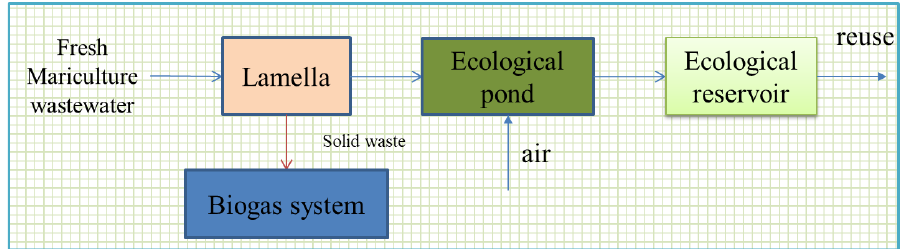
Figure 2. Biological nutrients removal of raw mariculture wastewater. Inclined tube settling tank (Lamella) is suggested for the removal of the fresh organic solids at a long hydraulic retention time (HRT). After concentration, the waste sludge enters into a sludge pressure filter or centrifugal dehydrator, and the mud cake is transported for centralized disposal and treatment. Anaerobic co-digestion of organic residual feed, excre- ments, waste sludge and algae can be used to produce methane for energy recovery [40]. The anaerobic digestion liquid is rich in nitrogen and phosphorus, which can be used for the cultivation of algae or irrigation of coastal constructed